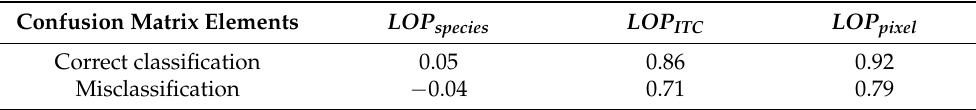
Table 3. Pearson’s correlation coefficient comparing LDA classification of DART simulations to imaging spectroscopy for LOP level scenarios. The consistency in correct classification and mis- classification is compared between classification results obtained from airborne acquisition and classification results obtained from simulations.